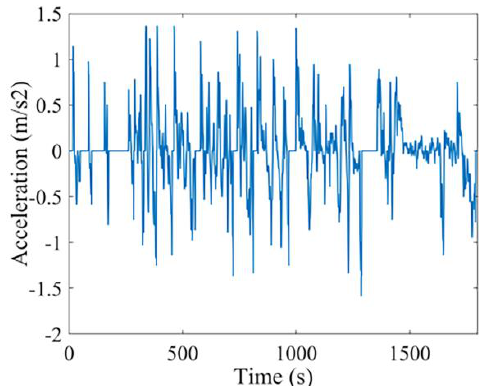
Figure 14. Acceleration.